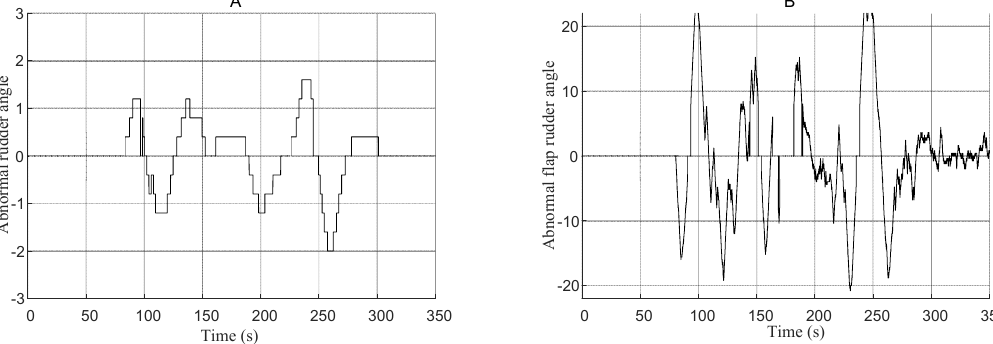
Figure 6. Data abnormalities of rudder and flap rudder. In ( A , B ), the abnormal data of ship rudder and flap rudder are first detected at 81.7 s and 80.4 s by Algorithm